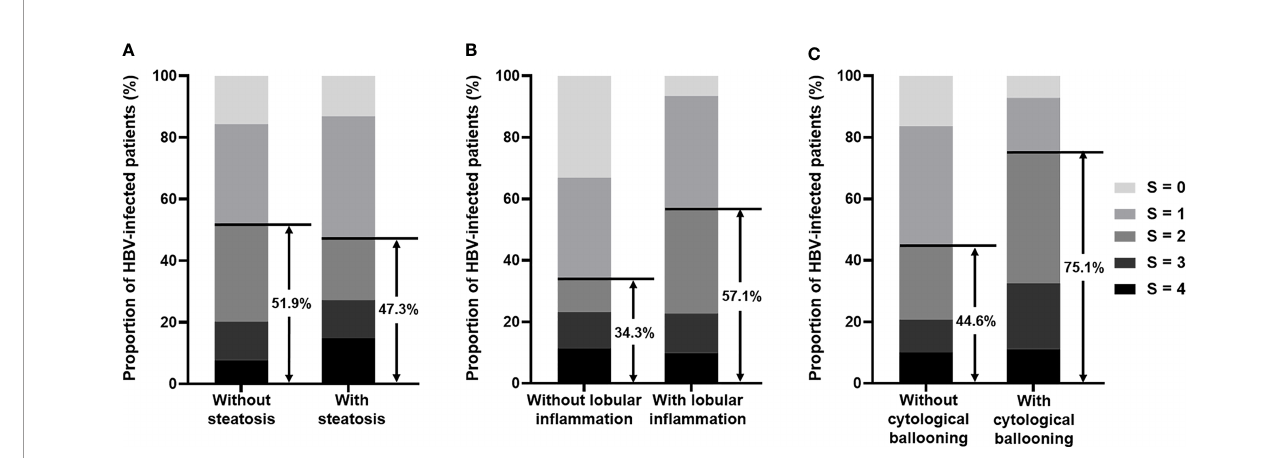
FIGURE 2 | (A) Bar chart illustrates the proportion of fi brosis stage in HBV-infected patients with or without steatosis. Among patients without steatosis, 51.9% had signi fi cant fi brosis (S ≥ 2), and among patients with steatosis, 47.3% had signi fi cant fi brosis (S ≥ 2). (B) Bar chart illustrates the proportion of fi brosis stage in HBV- infected patients with or without lobular in fl ammation. Among patients without lobular in fl ammation, 34.3% had signi fi cant fi brosis (S ≥ 2), and among patients with lobular in fl ammation, 57.1% had signi fi cant fi brosis (S ≥ 2). (C) Bar chart illustrates the proportion of fi brosis stage in HBV-infected patients with or without cytological ballooning. Among patients without cytological ballooning, 44.6% had signi fi cant fi brosis (S ≥ 2), and among patients with cytological ballooning, 75.1% had signi fi cant fi brosis (S ≥ 2). HBV, hepatitis B